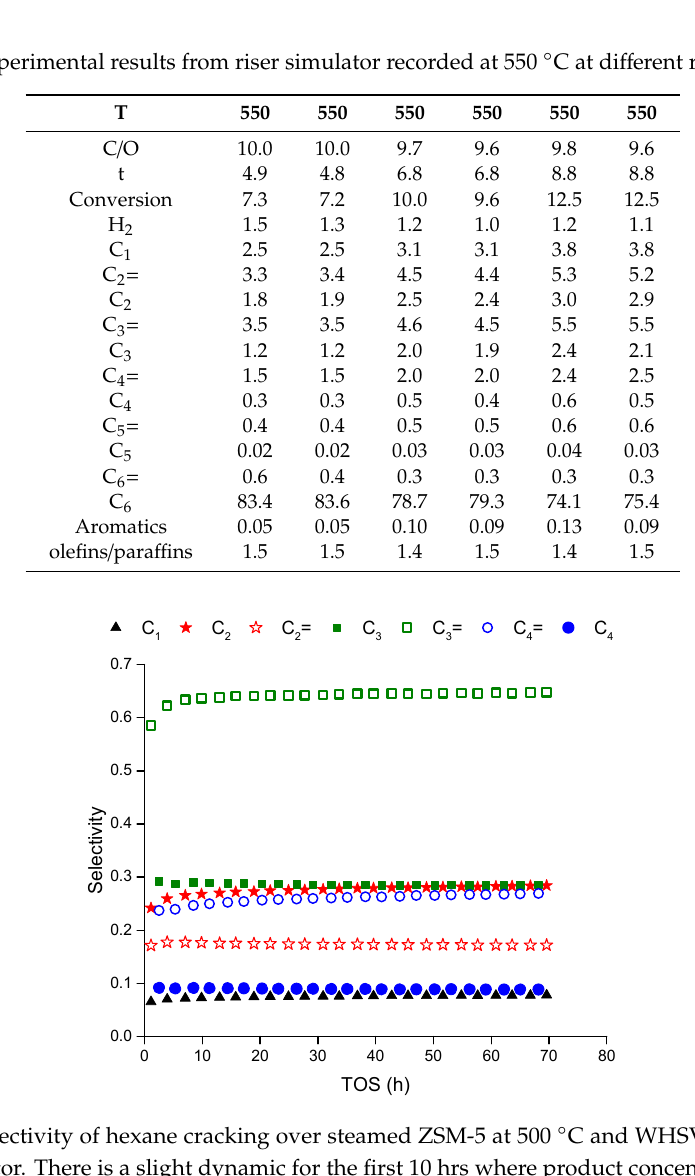
Table A1. Experimental results from riser simulator recorded at 550 °C at different residence time. T